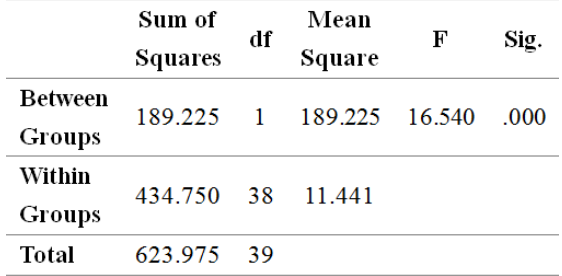
Figure 1. Comparison of scores pre and post work-shop using the rubric REC One-way ANOVA identified significant differences between the scores obtained at the pre and post measurements (F=16.54, df=39, p<.001), as shown in Table 3. Thus, there were changes in participant teachers’ ways of explaining after peer assessment based on the rubric, which suggest an advance in this cru- cial teaching practice. Table 3. ANOVA one-way pre and post